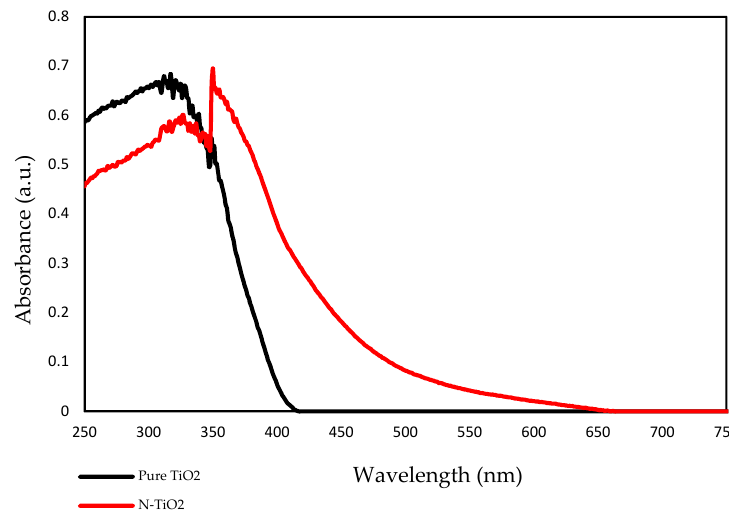
Figure 4. UV-Vis absorption spectrum of pure TiO 2 and N-TiO 2 .